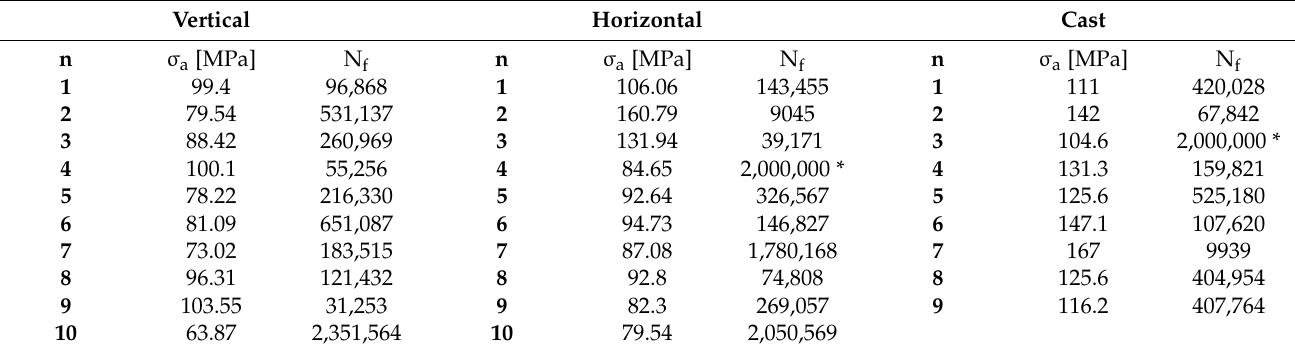
Table 3. Experimental results of the cyclic test of AlSi10Mg.